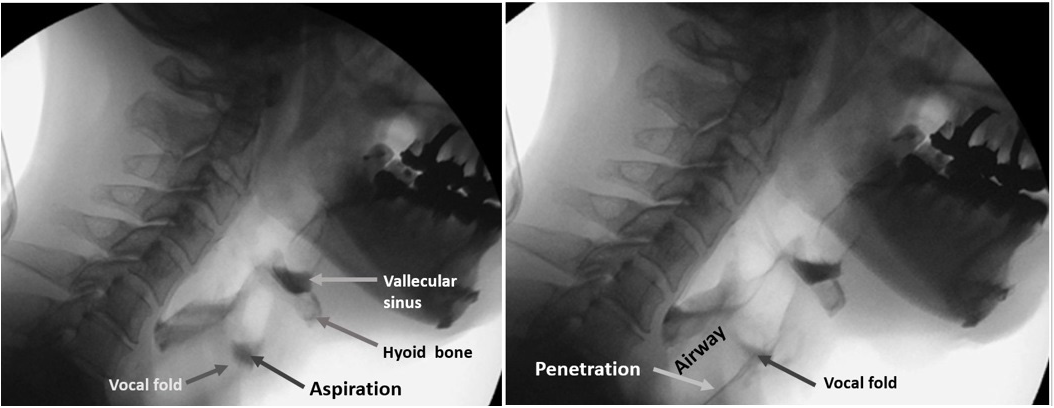
Figure 8. Sample VF images. Left image shows the aspiration and right image shows penetration. Observers recorded these findings on the VF exam chart. These VF exam charts were used for the classification of a dysphagia (+) case and ( − ) case. In this study, penetration and aspiration cases were treated as a dysphagia (+)